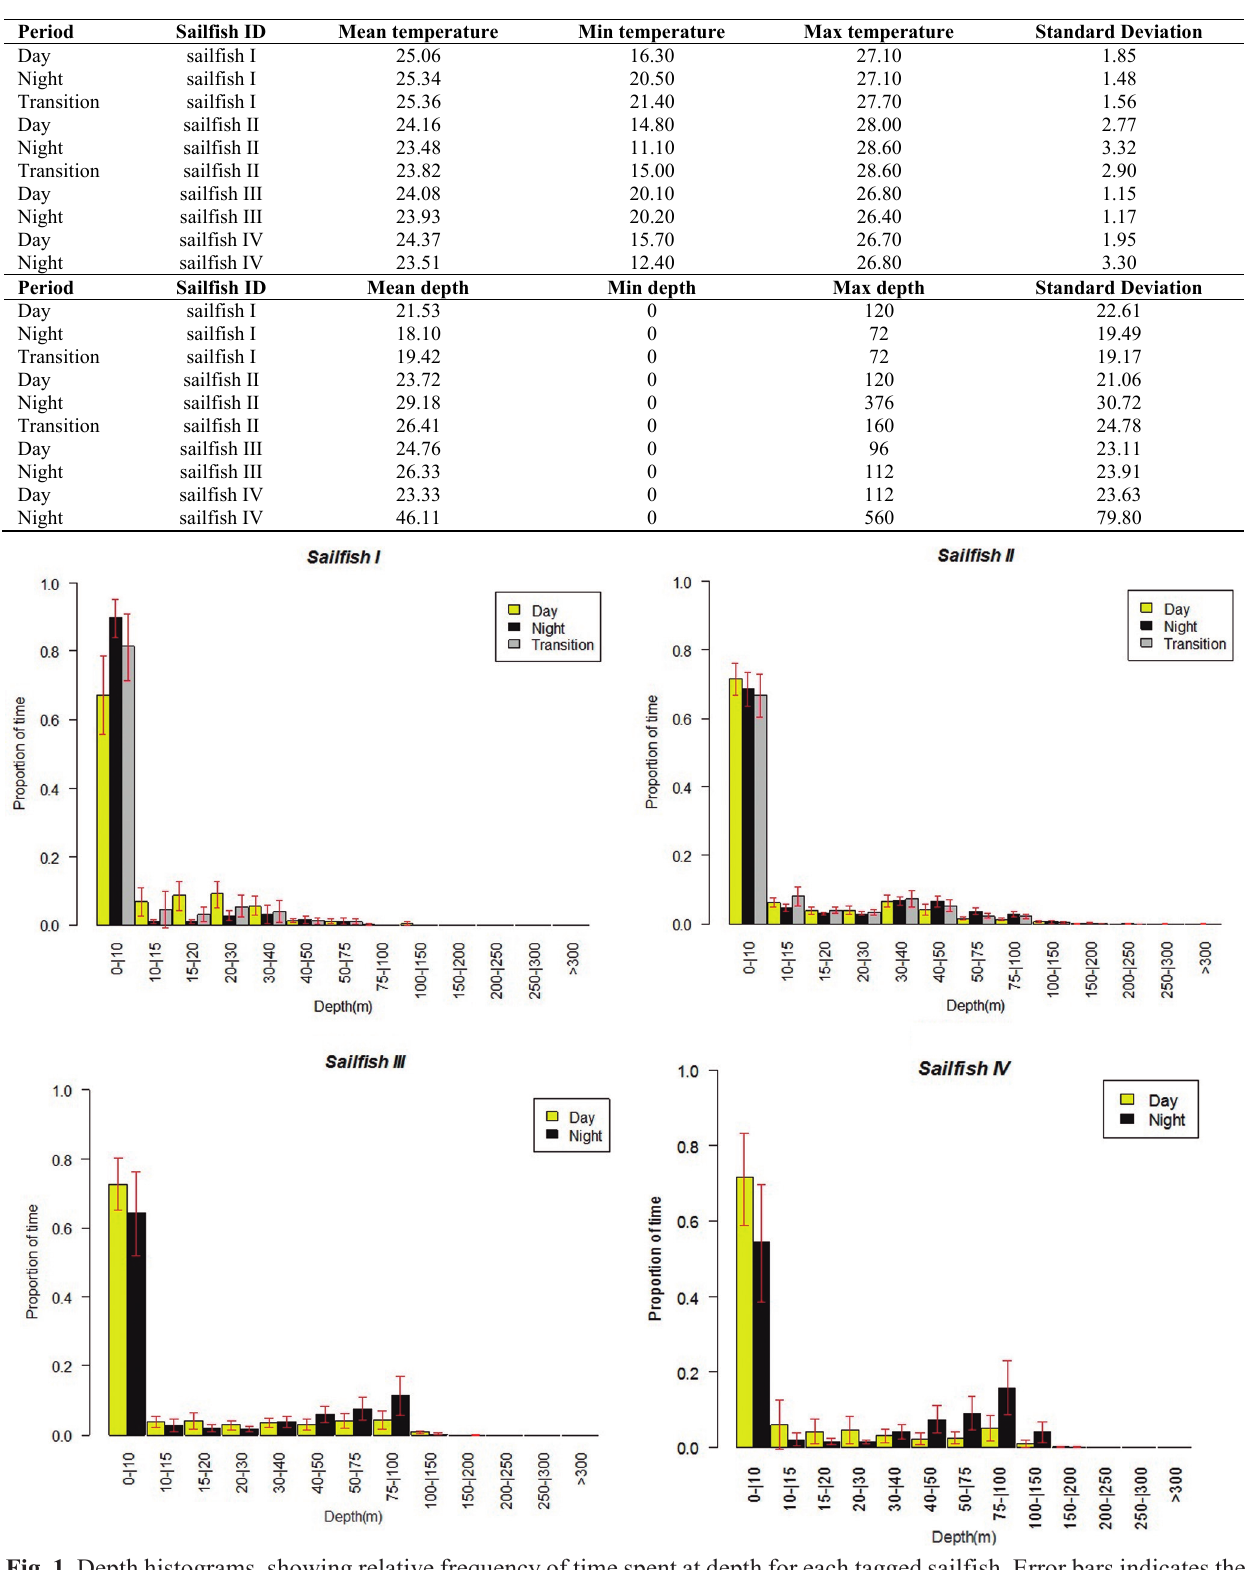
Table 2. Mean, minimum, maximum temperatures and depths with the respective standard deviation experienced by tagged sailfish during the tracked period by fish and period.